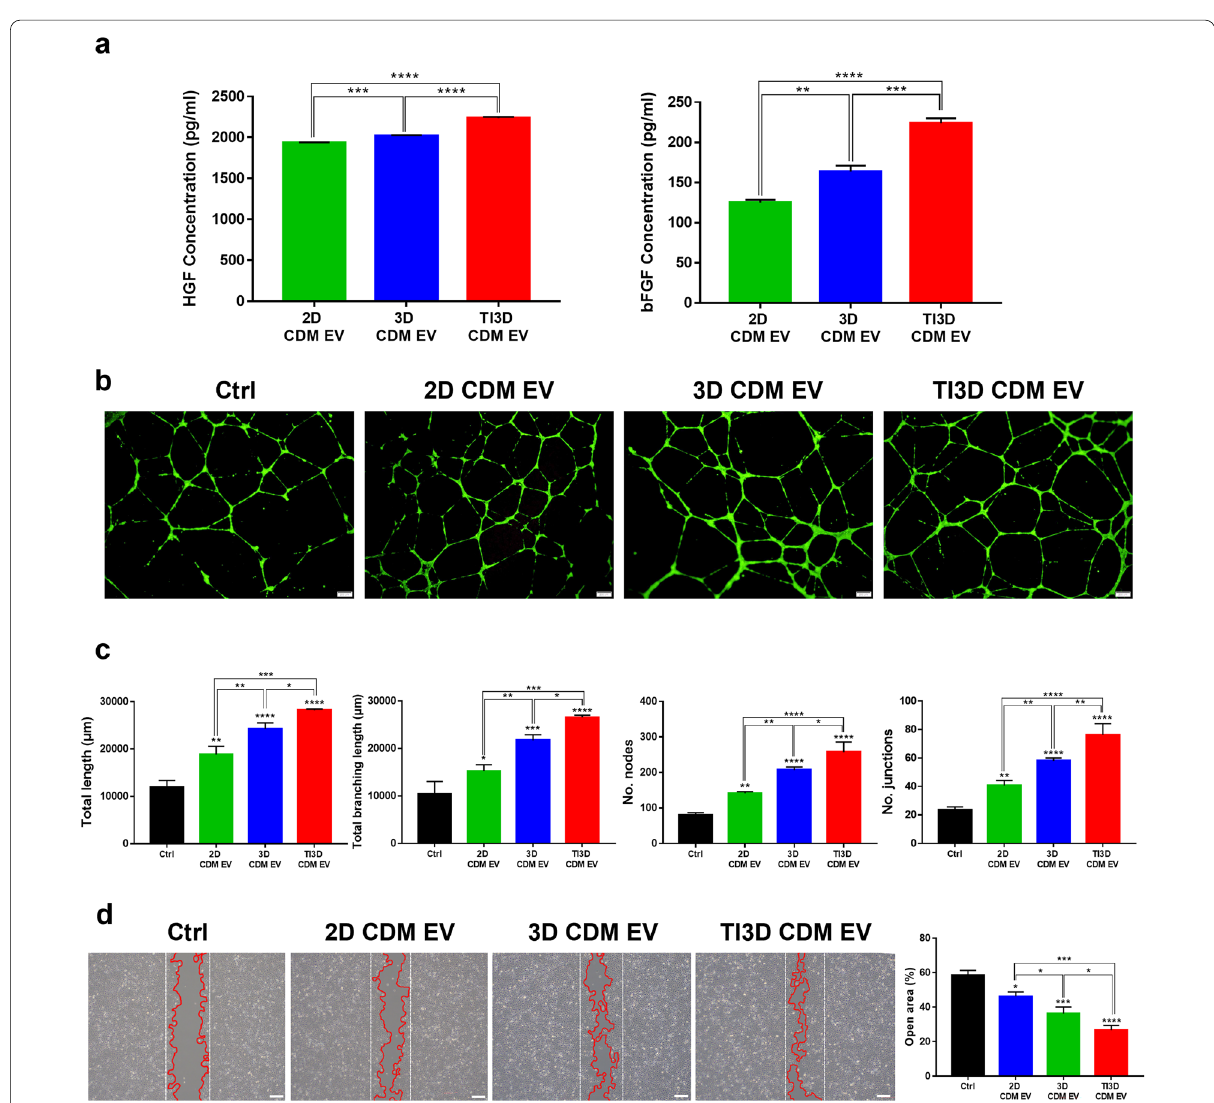
Fig. 5 Angiogenesis and wound healing effects of EVs. a The HGF and bFGF levels of EVs. b Representative images of angiogenesis effect by tube formation assay of EVs. c Analysis of total length, total branching length, number of nodes, and number of junctions from tube formation assay. d The representative images of cell migration assays to evaluate wound healing effects of EVs, and calculated wound healing rates of EVs. (Analysis with Image J; Values are presented as mean SD (n 3) and statistical significance was obtained with one‑way analysis of ANOVA with Tukey’s ± = multiple comparison post‑test (* p < 0.05; ** p < 0.01; *** p < 0.001; **** p <